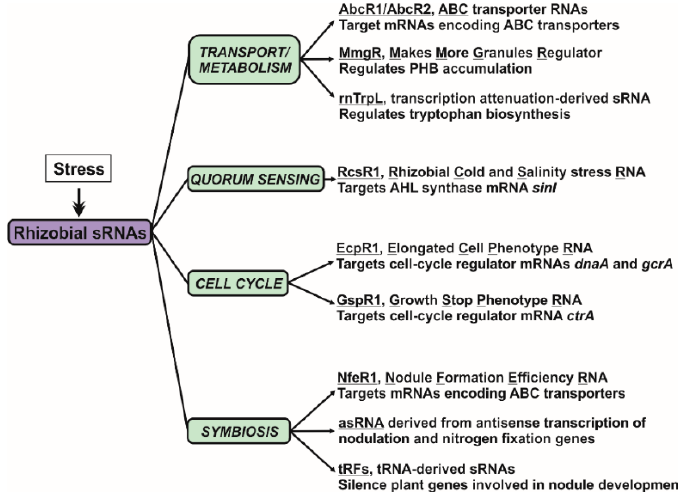
Figure 4. Cell processes that are riboregulated in rhizobia and the sRNAs involved.